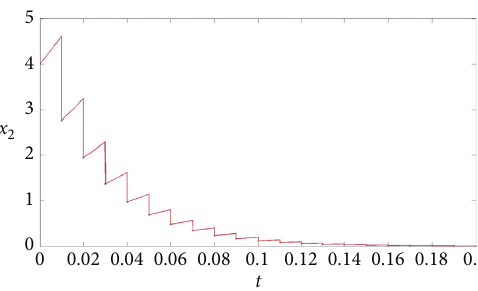
Figure 8: The trajectory of the state x coefficients a � 35, b � ( 8/3 ) , c � 25, t k � 0 . 01 k ( k � 1 , 2 , ... , ) , d � 0 ( i,j � 1 , 2 , 3 ,i ≠ j ) , and d ij condition x ( 0 ) � ( 3 , 4 , 5 ) T .